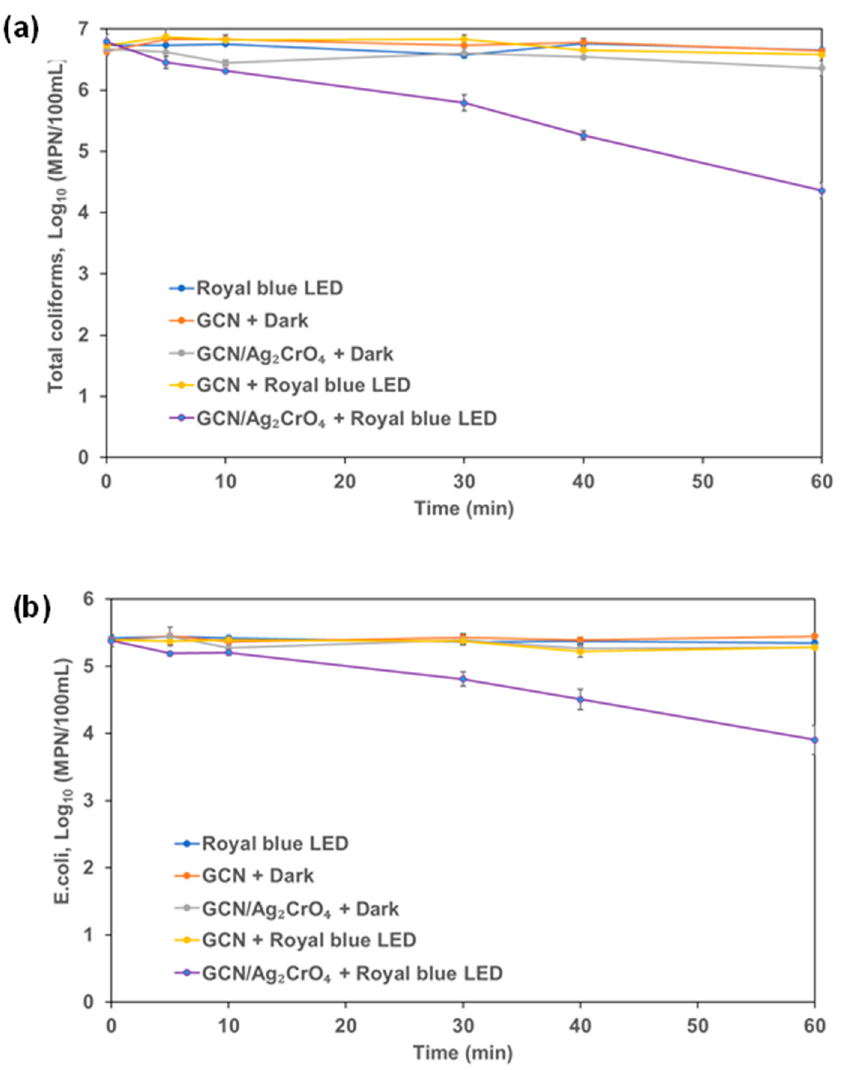
Figure 7. Coliforms in wastewater secondary effluent: ( a ) total coliforms and ( b ) E. coli. Zhang et al. investigated the impact of light irradiation on the reduction of Ag + to AgNPs by bacteria and reported that visible lights (monochromatic light at wavelengths 415 nm and 600 nm) accelerated the reduction of Ag + to AgNPs by bacteria and almost no